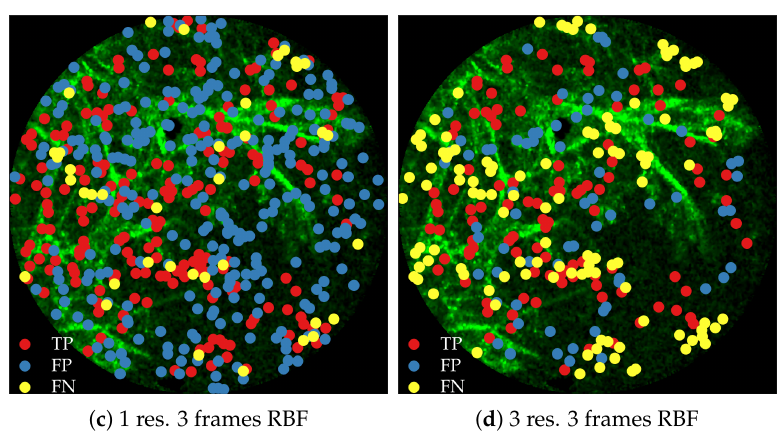
Figure 11. Ground truth annotations and detected bacteria at threshold 0.8.